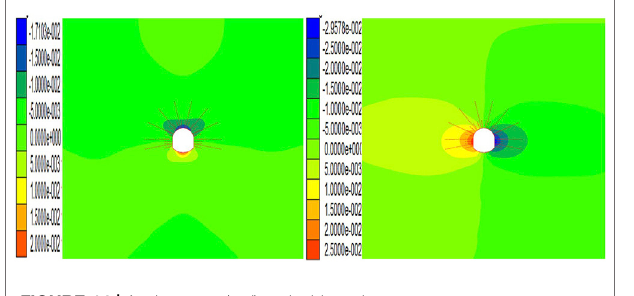
FIGURE 14 | Anchor rope (rod) – a double arch truss support displacement.